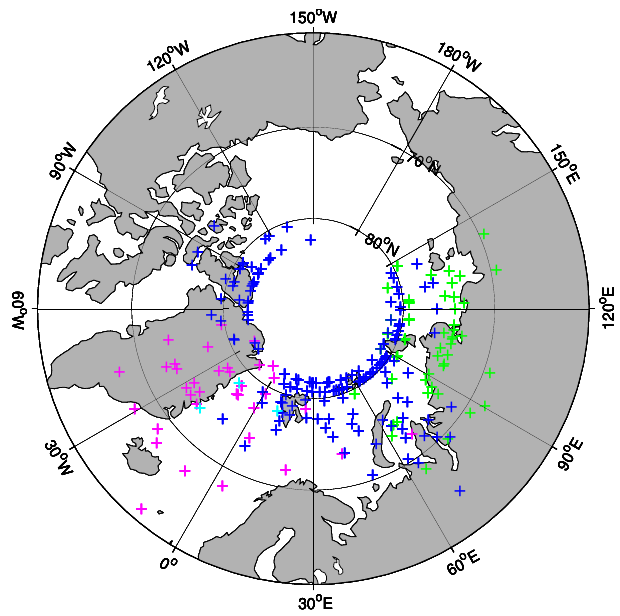
Figure 1. Start points where the back trajectories were started ac- cording to the PSCs observed by CALIPSO during the four cold phases during the Arctic winter 2010/11 (Phase 1: 23 December– 8 January (magenta), Phase 2: 20–28 January (green), Phase 3: 5– 27 February (blue) and Phase 4: 5–18 March (cyan)).